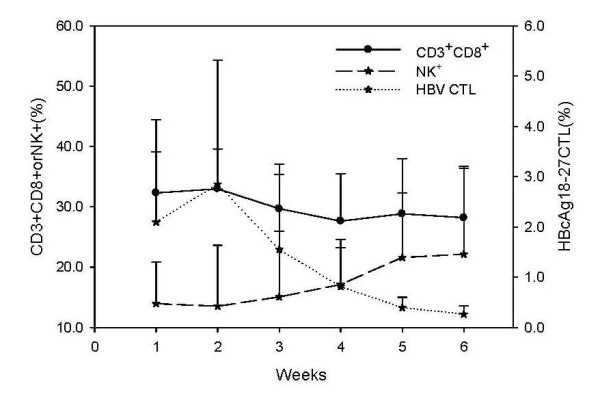
The relationship between peripheral blood lymphocyte subsets and HBV-specific CTLs. Dots indicate the mean value. CD3+CD8+ cells and HBcAg18-27-specific CTLs of AHB patients reached peak levels at the second week after admission. There was a positive correlation between them (r = 0.492, p = 0.01). The number of NK cells was negatively correlated with the frequency of the HBV specific CTLs in AHB patients (r = -0.266, p = 0.05).